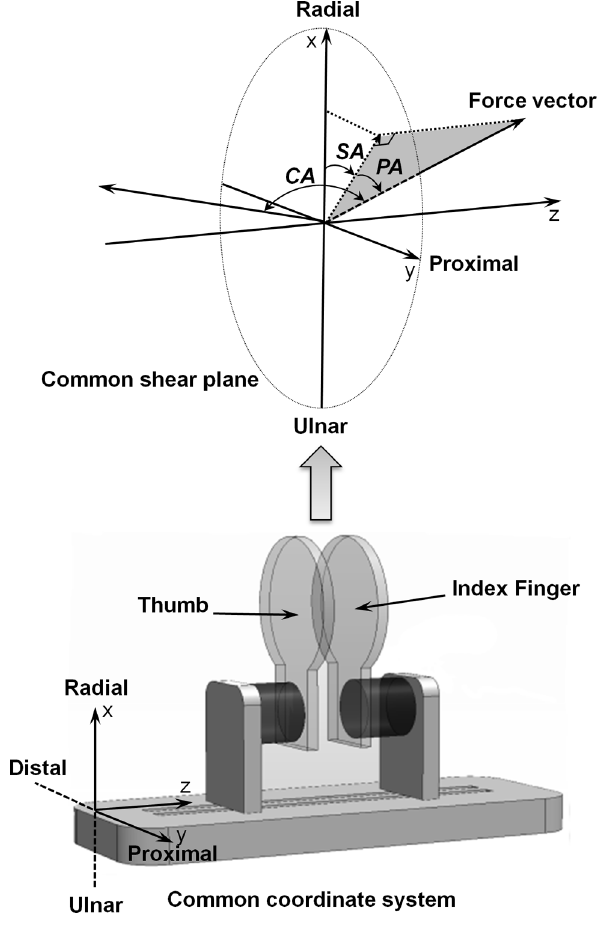
Figure 2. Definition of coordinate system and angular param-